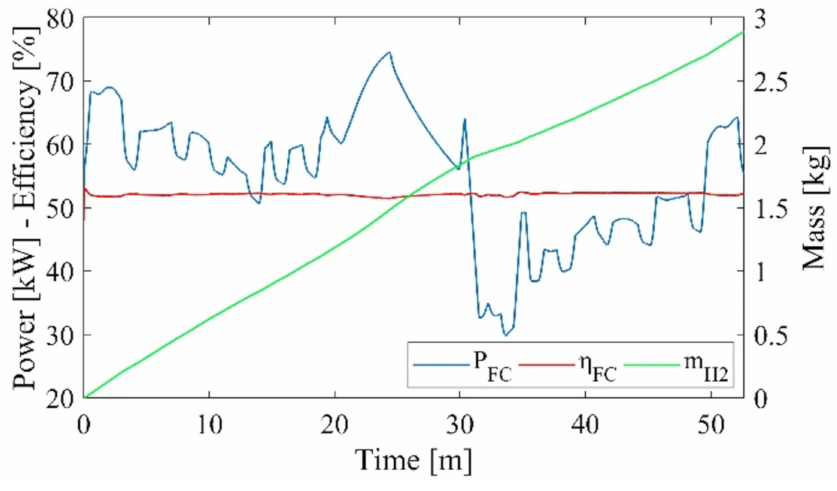
Figure 6. Fuel cell